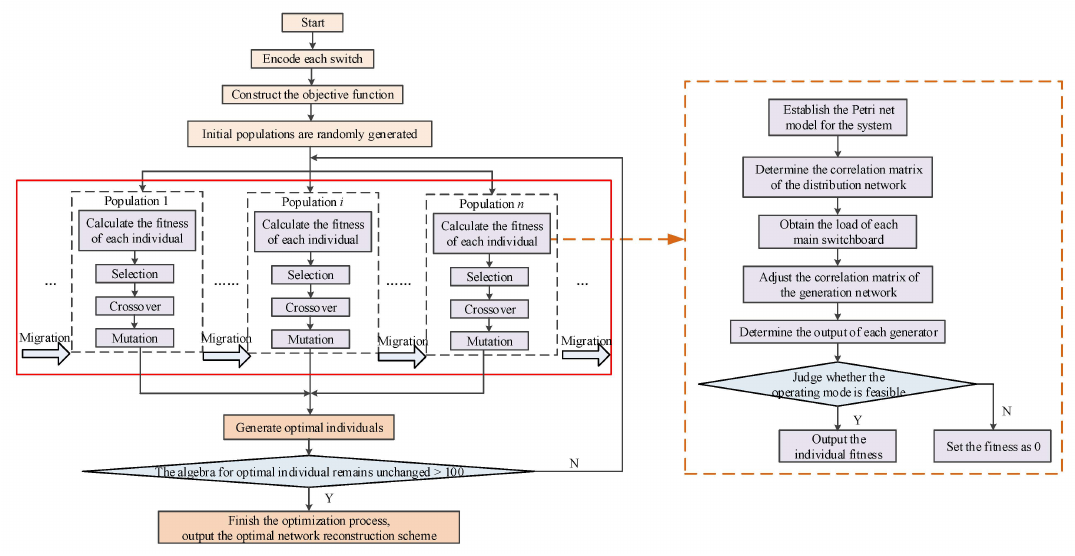
Figure 7. Network reconstruction process.